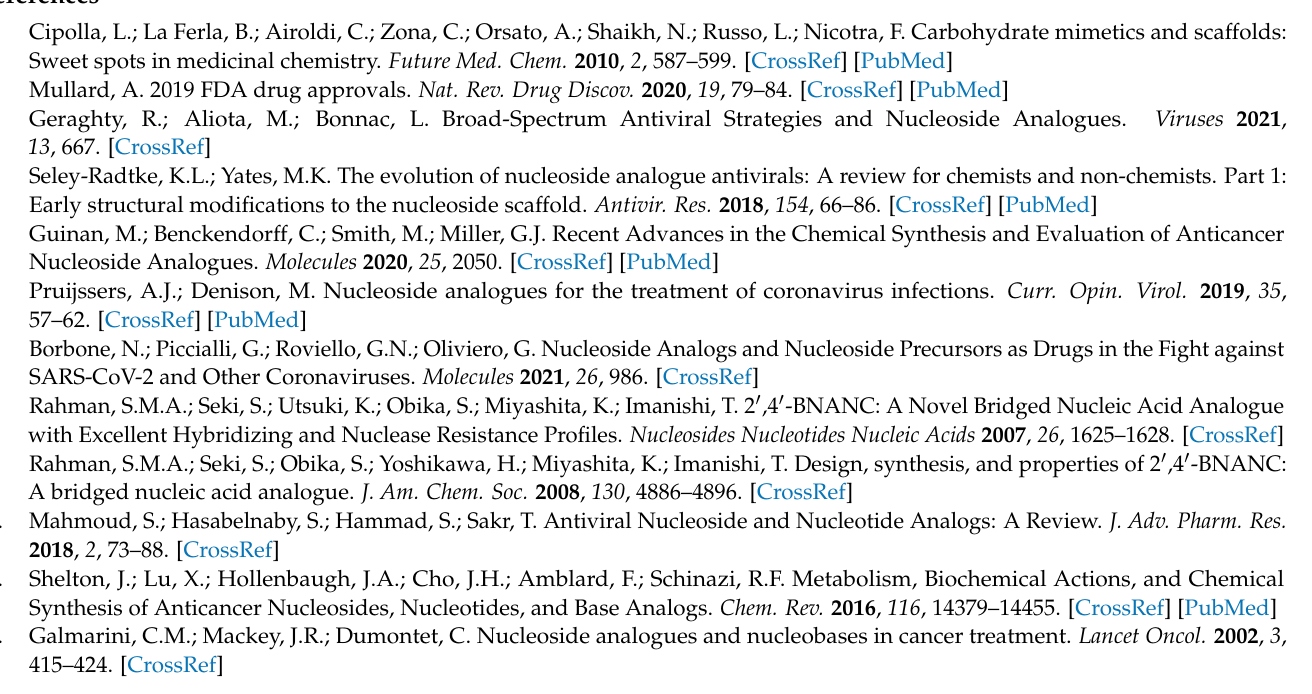
of compound 2a ; Figure S4: 1H NMR spectrum of compound 2c ; Figure S5: 1H NMR spectrum of com- pound 3 ; Figure S6: 1H NMR spectrum of compound 3a ; Figure S7: 1H NMR spectrum of compound 4 ; Figure S8: 1H NMR spectrum of compound 5 ; Figure S9: 1H NMR spectrum of compound 6 ; Figure S10: 1H NMR spectrum of compound 3e ; Figure S11: 1H NMR spectrum of compound 3f ; Figure S12: 1H NMR spectrum of compound 3g ; Figure S13: 1H NMR spectrum of compound 3h ; Figure S14: 1H NMR spectrum of compound 7 ; Figure S15: 1H NMR spectrum of compound 8 ; Figure S16: 1C NMR spectrum of compound 8 ; Figure S17: MALDI-TOF mass spectra of spectrum of compound 8